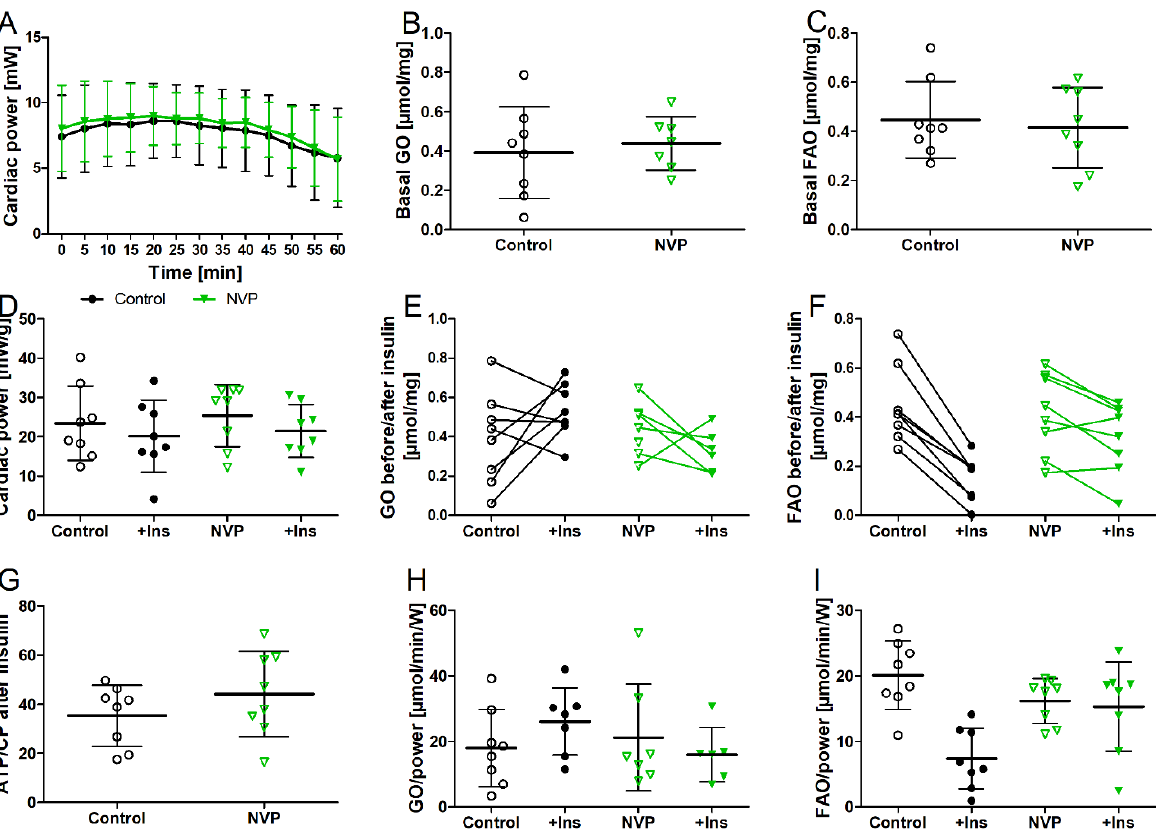
Figure 5. Effects of acute NVP-AEW541 (NVP) application on isolated working hearts. Cardiac